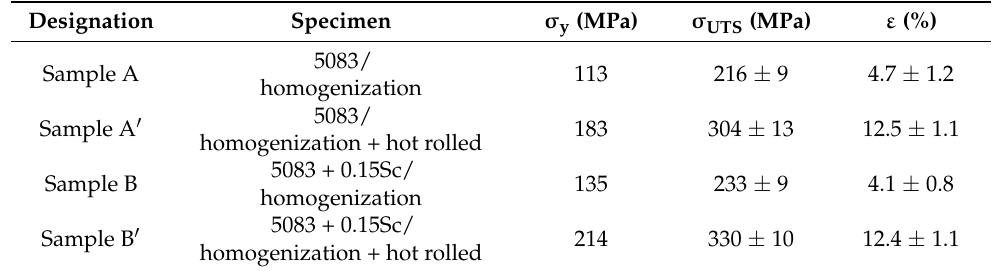
Table 2. Tensile properties of Sc-free/microalloyed Al5083 alloys with/without the hot-rolling process.